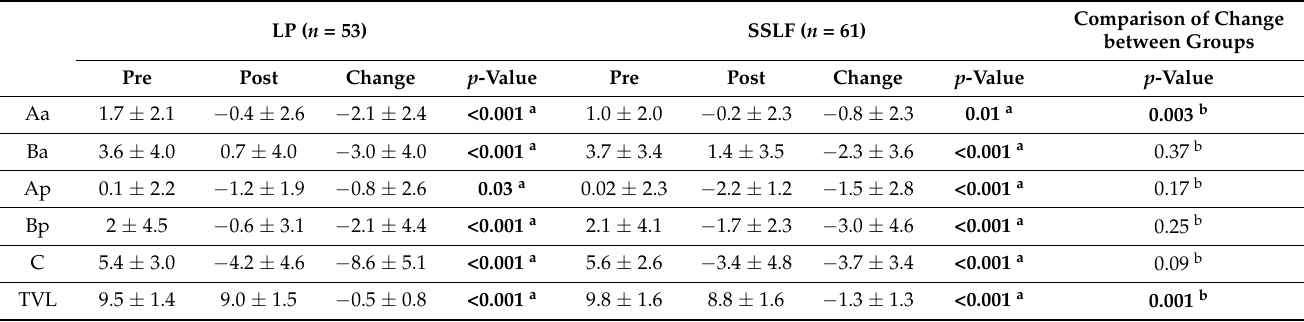
Table 3. POP-Q measurements: baseline and at follow-up (in centimeters).